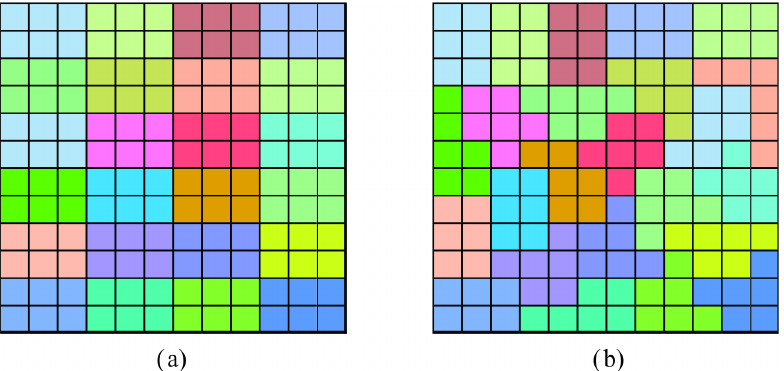
Figure 2. Comparison of the subarray shape: ( a ) first quadrant array structure before optimizing the subarray shape (regular shape), and ( b ) first quadrant array structure after optimizing the subarray shape (aperiodic